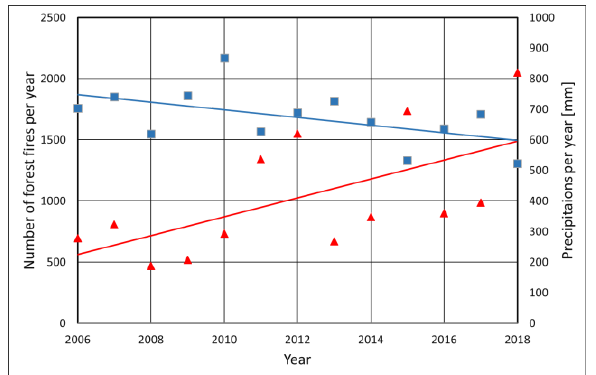
Figure 1. History of the forest fires and precipitation in recent years in the Czech Republic.